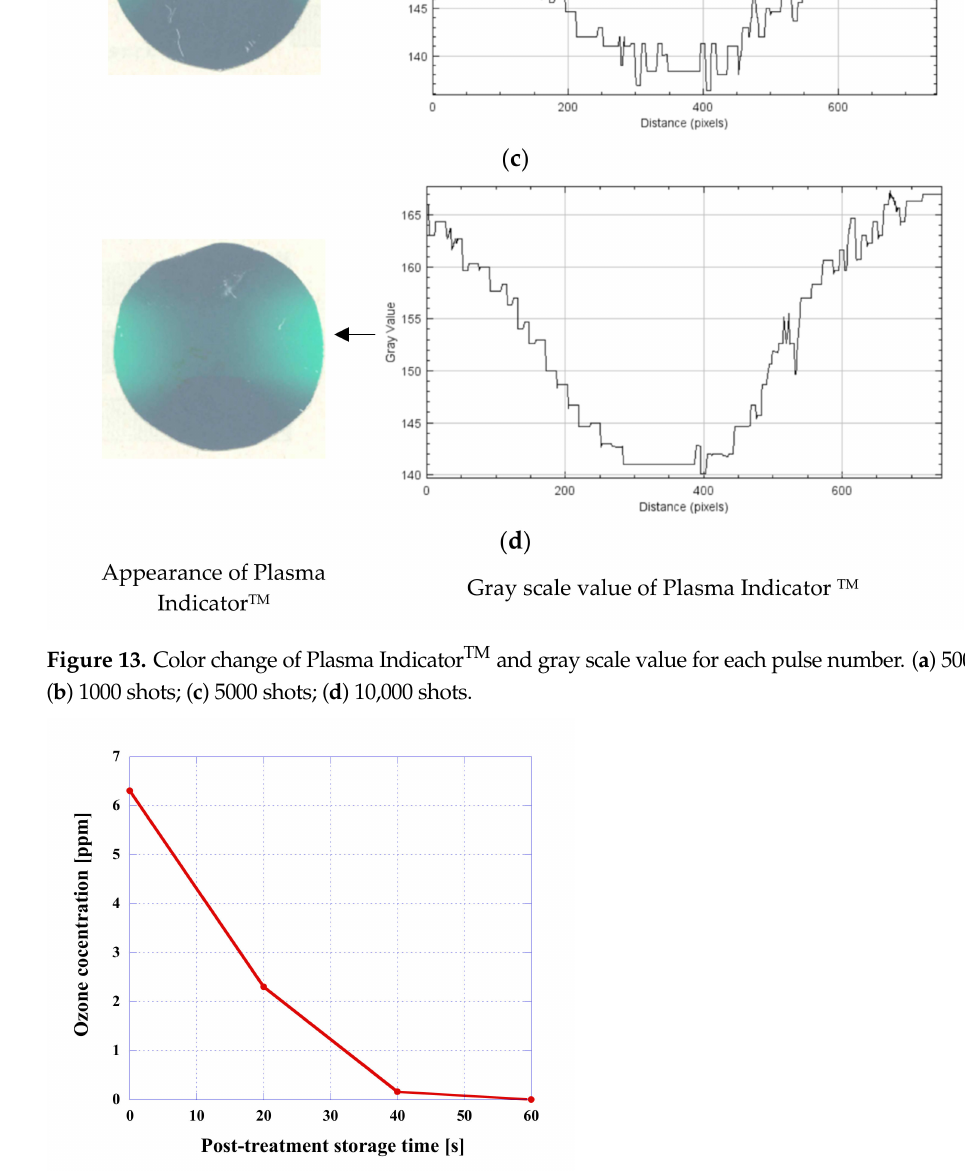
Figure 14. Ozone concentration in petri dish for elapsed time after pulse application. (Agar medium configuration (1); applied pulse voltage: 70 kV; applied pulse number: 100